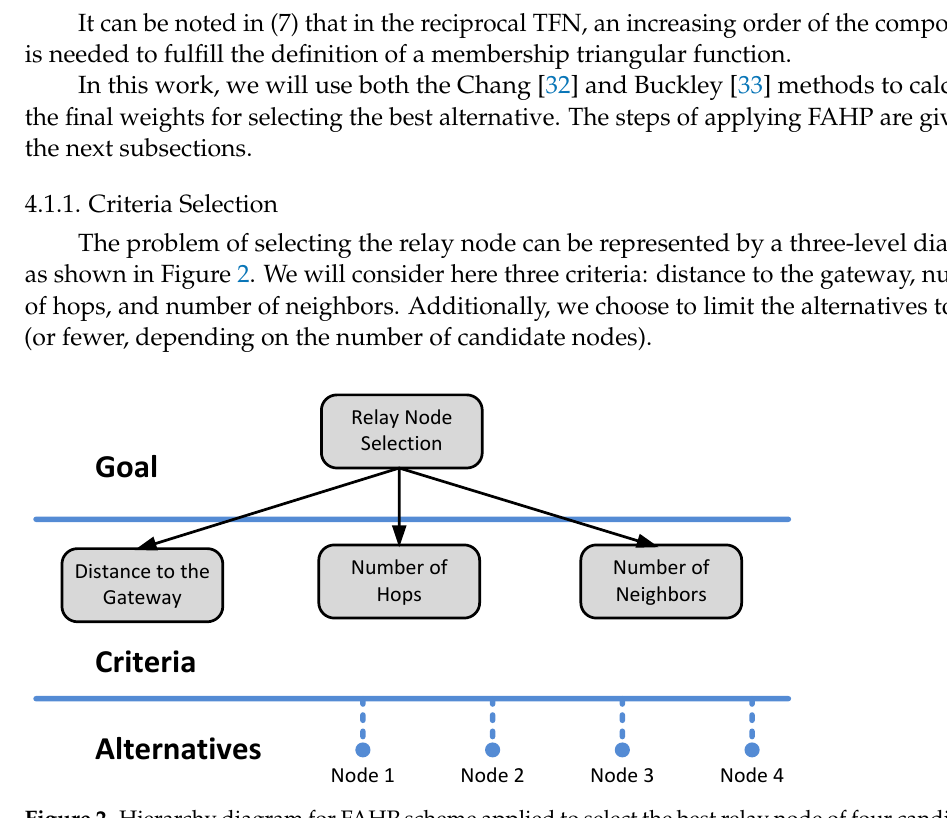
Figure 2. Hierarchy diagram for FAHP scheme applied to select the best relay node of four candi- dates.